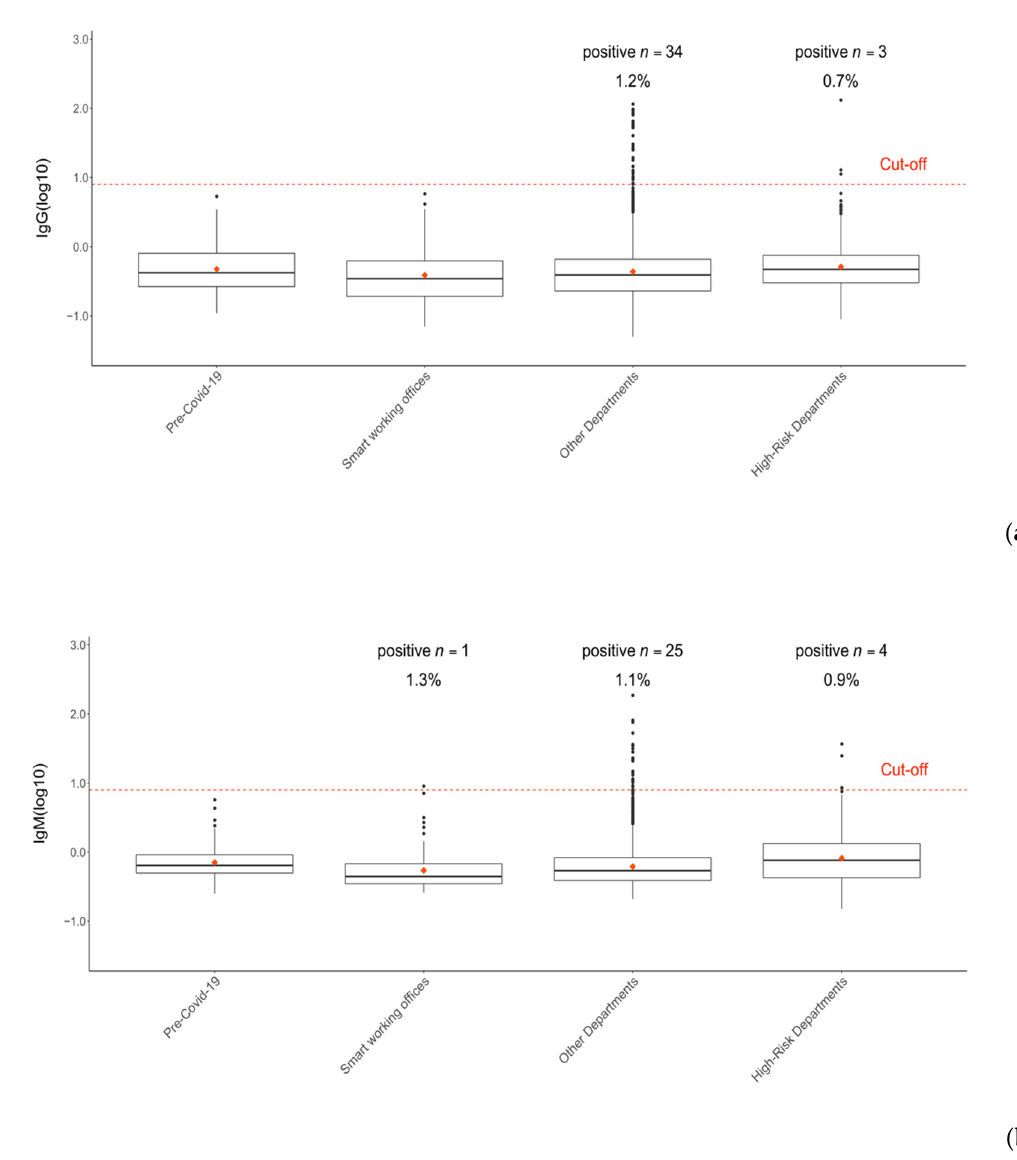
Figure 3. Stratified seroprevalence trends at Foggia Hospital” “Policlinico Riuniti” during the COVID-19 outbreak and lockdown (17 March to 18 May 2020). IgG ( a ) and IgM ( b ) seroprevalence of 3242 hospital employees stratified by departments. Ig values are expressed as log 10 of the original concentration (AU / mL). Cut-o ff was set at 8 AU / mL (log 10 (8) =